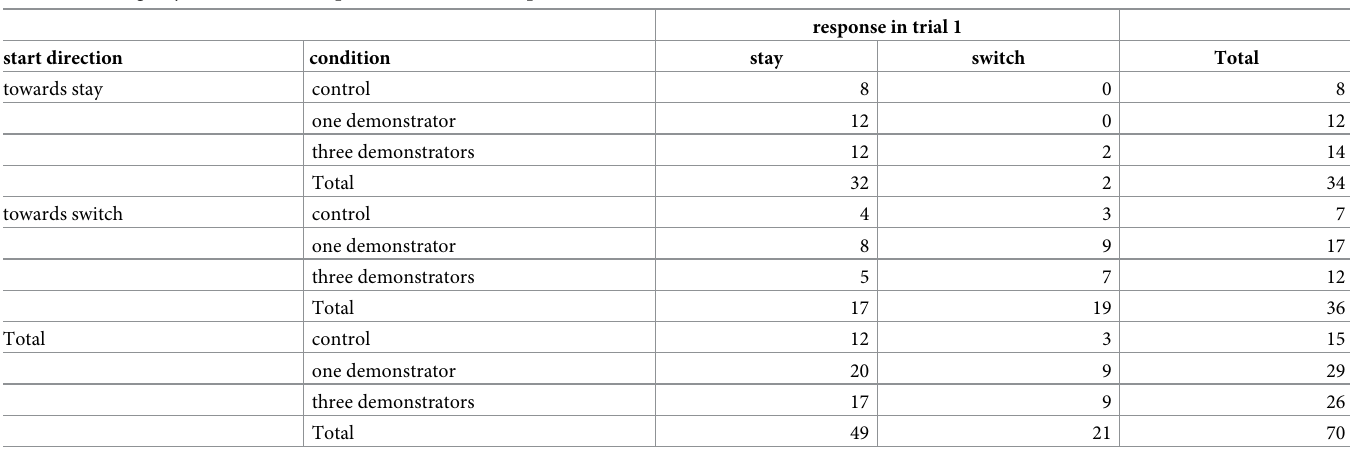
Table 4. Contingency tables for the complete and each